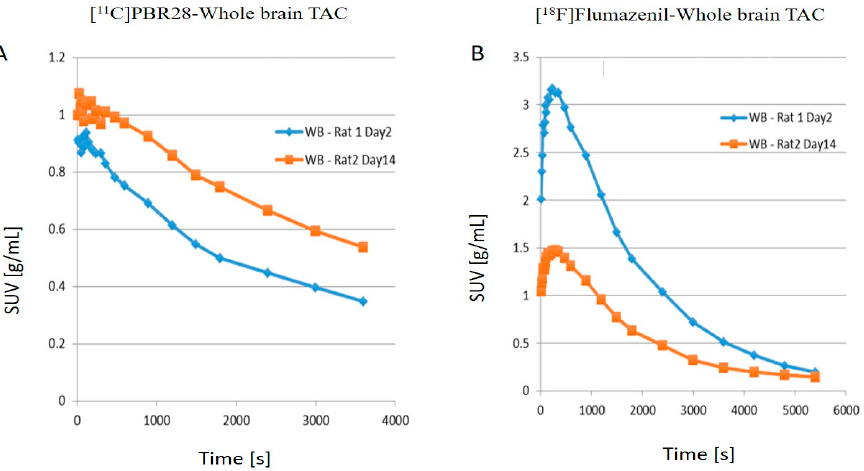
Figure 2. ( A ) [ 11 C]PBR28 and ( B ) [ 18 F]flumazenil whole brain time activity curves (TACs) for Rat1 day 2 post-op and Rat2 day 14 post-op.